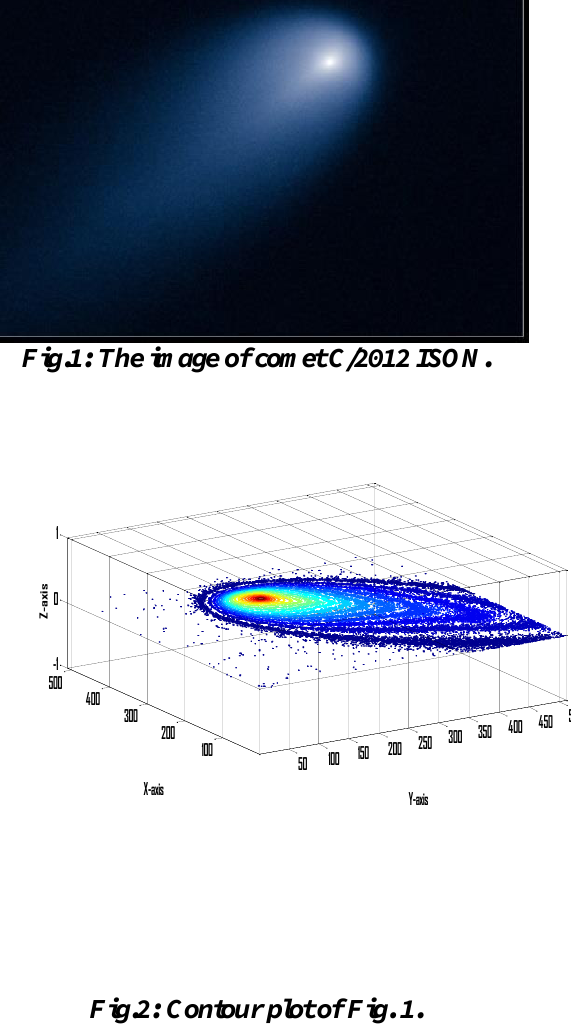
Fig.2: Contour plot of Fig.